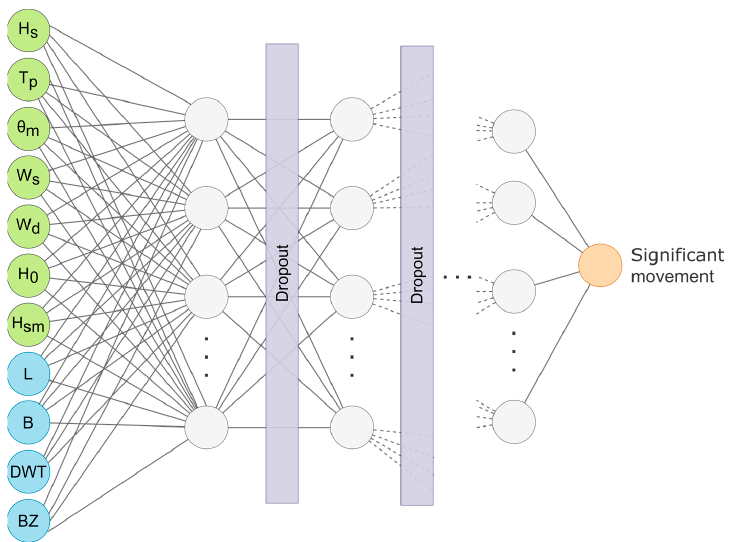
Figure 4. Overall structure of the ANNs created.